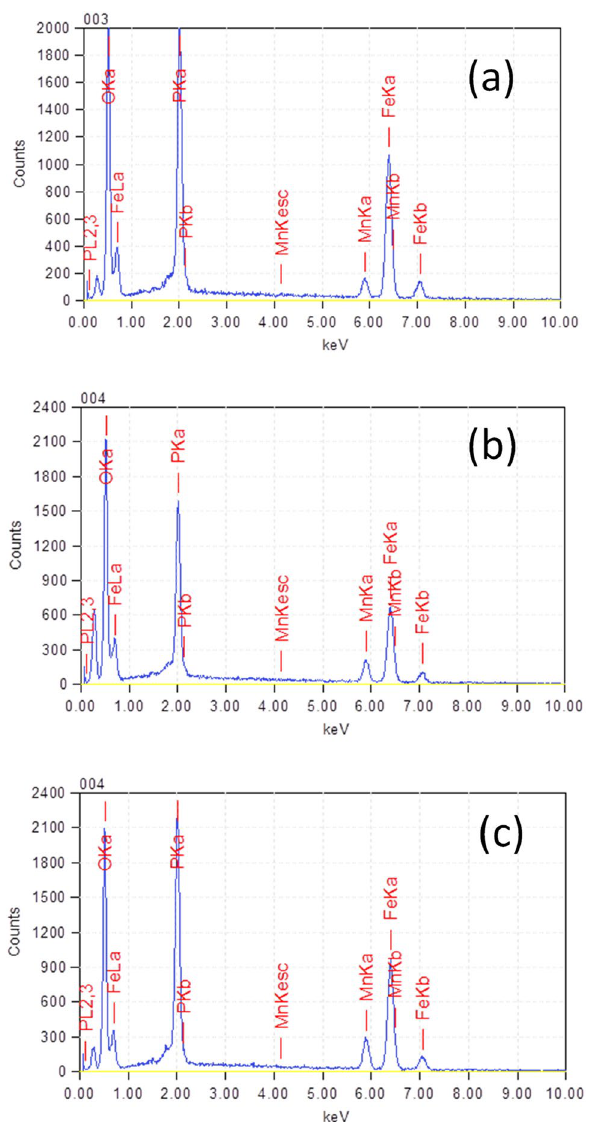
Figure 3. EDS spectra of Mn-doped olivine samples ( a ) LiMn 0.1 Fe 0.9 PO 4 ; ( b ) LiMn 0.2 Fe 0.8 PO 4 and ( c ) LiMn 0.3 Fe 0.7 PO 4 .